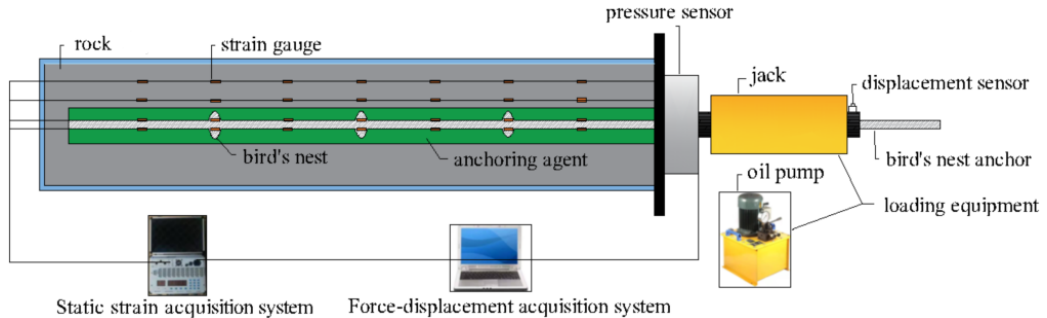
Figure 3. Pulling ‐ out cable test system. Figure 3. Pulling-out cable test